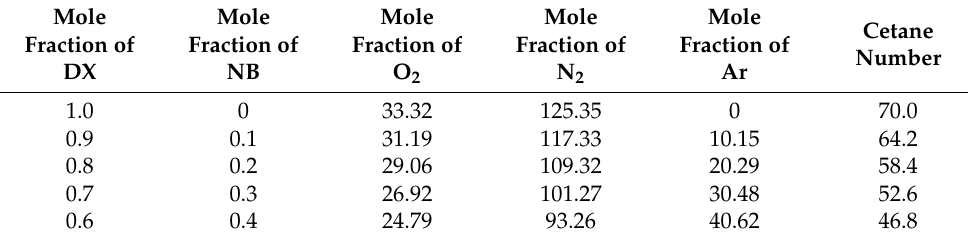
Table 3. Species composition ratio and cetane number of DX-NB